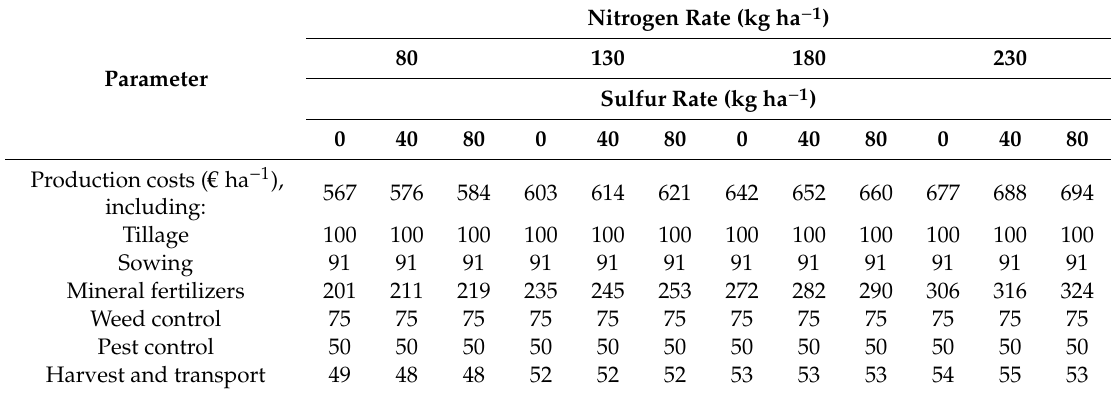
Table 9. Production costs of the semi-dwarf hybrid cultivar of winter oilseed rape (cv. PR44 D06), across years.